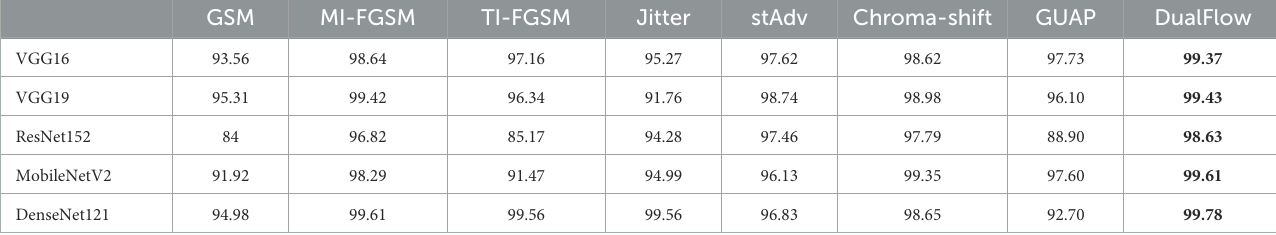
TABLE 3 Experimental results on attack success rate (ASR) of un-targeted attack of ImageNet. GSM